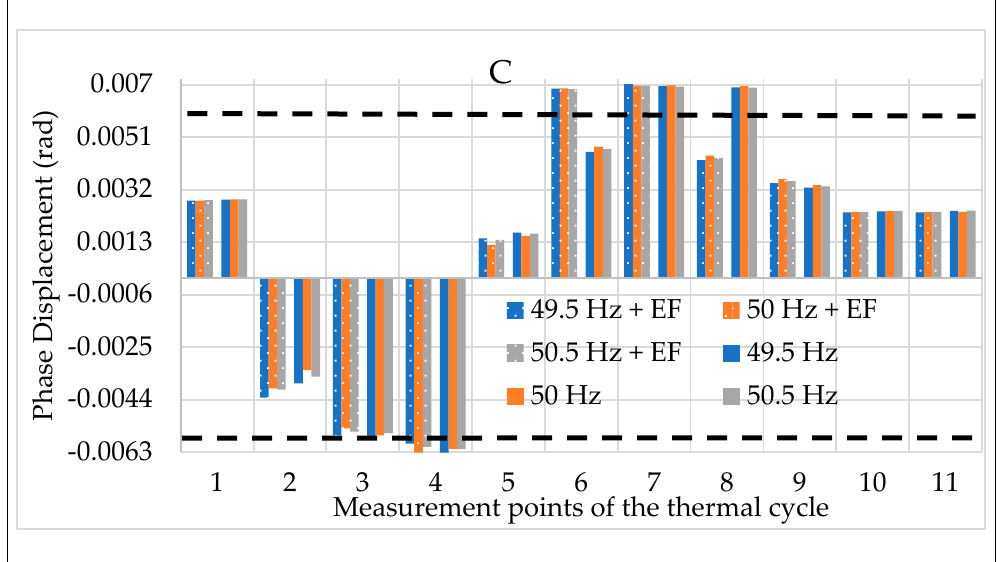
Figure 22. Phase displacement vs. the three influence quantities for LPVT C.